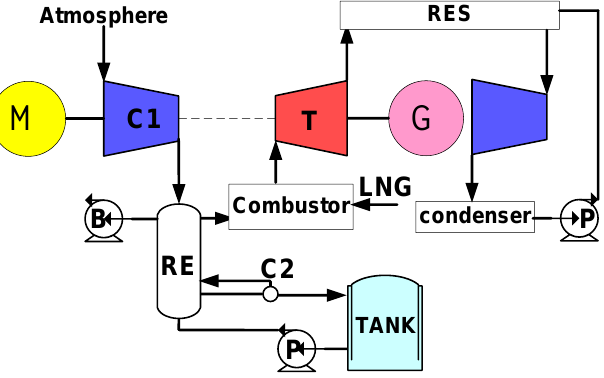
Figure 9. Schematic diagram of LAES system (B—Blower, C—Compressor, T—Turbine, G—Generator, M—Motor, P—Pump, RE—Heat regenerator, RES—Waste heat generator) [37].